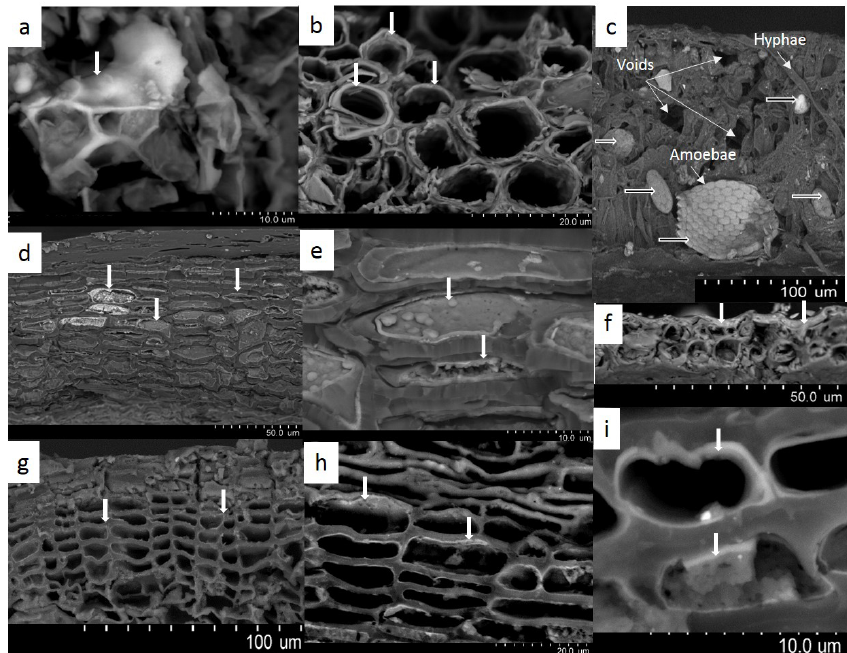
Figure 1. Si in biological tissues of beech trees observed with scanning electron microscopy. (a) Si precipitates in the intercellular space of fresh leaves, forming phytoliths (vertical white arrow). Deposits of Si (white arrows) in the inner cell walls of fruit capsules (b) , stem bark ( d and e ), bud scales (f) and roots ( g , h and i ). (c) Hyphae, testate amoebae and large voids in aged litter leaves. Si deposits are only present in the testate amoeba shells (horizontal empty white arrows). The presence of Si was confirmed with EDX (analysed zones indicated by white vertical